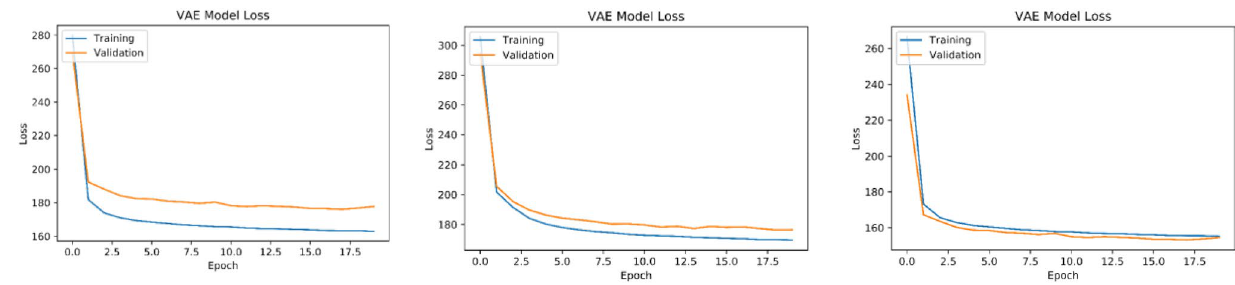
Fig. 15 Standard neural VAE performance (top left), LSTM-VAE performance (top right), BI-LSTM VAE performance